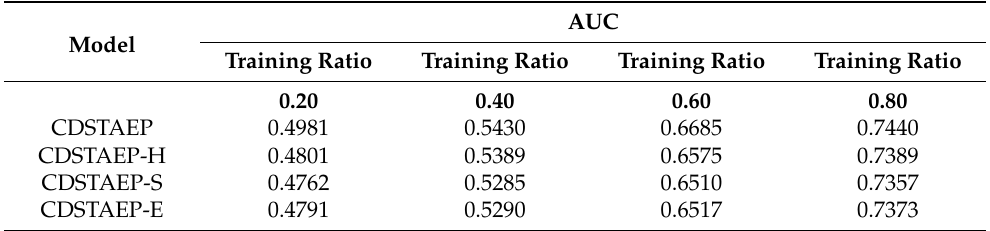
Table 6. AUC for prediction by different representation spaces on the dataset.